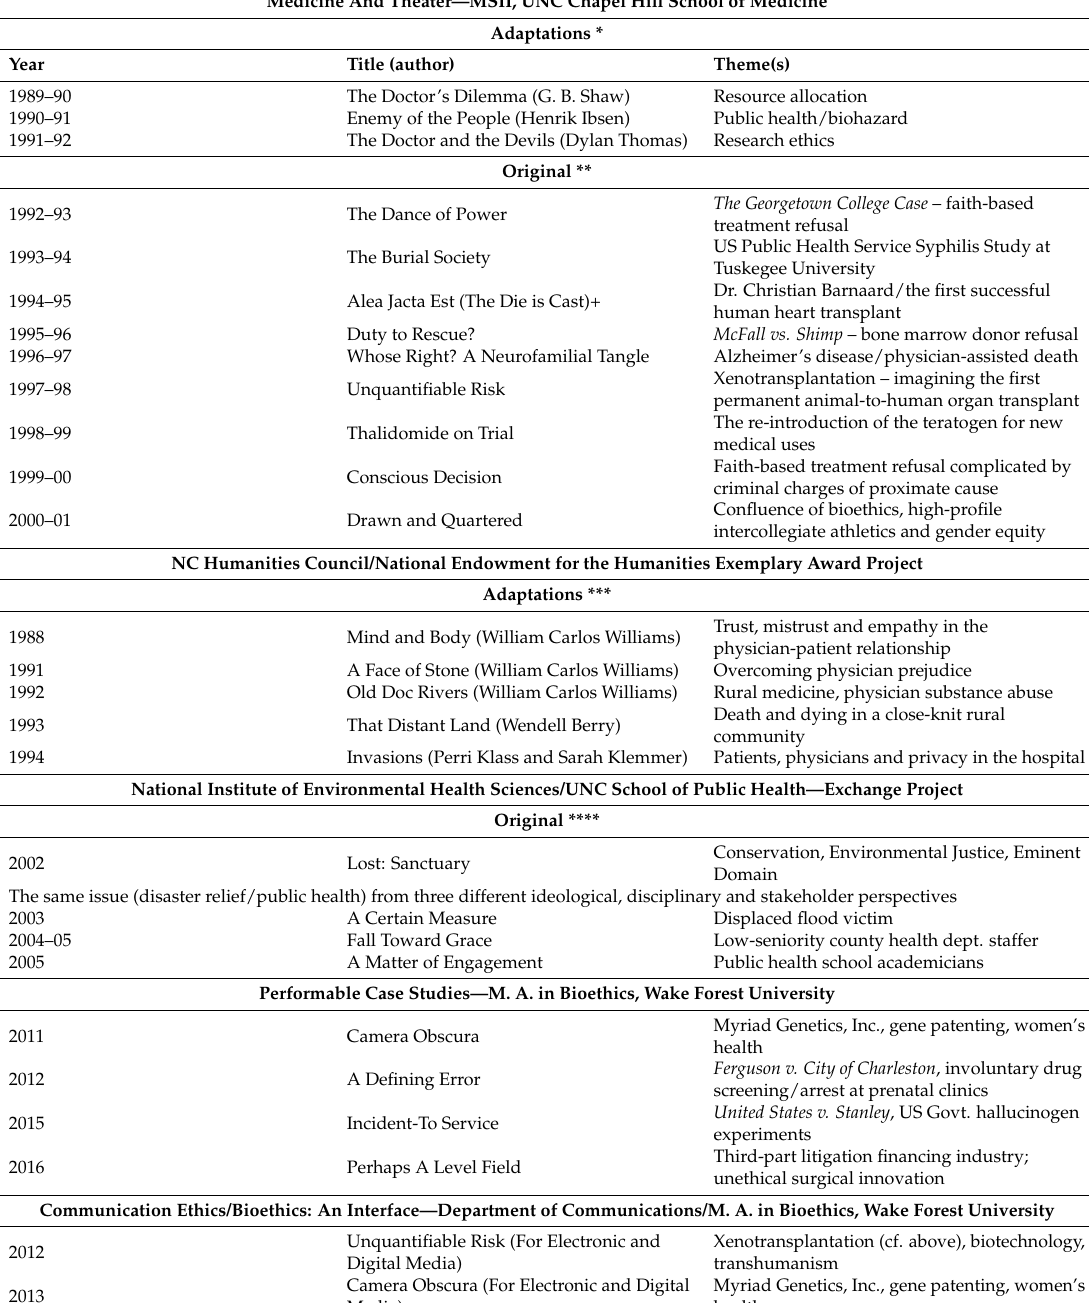
Table 1. Performable Case Studies 1988–2016. Subject/Issue Areas and